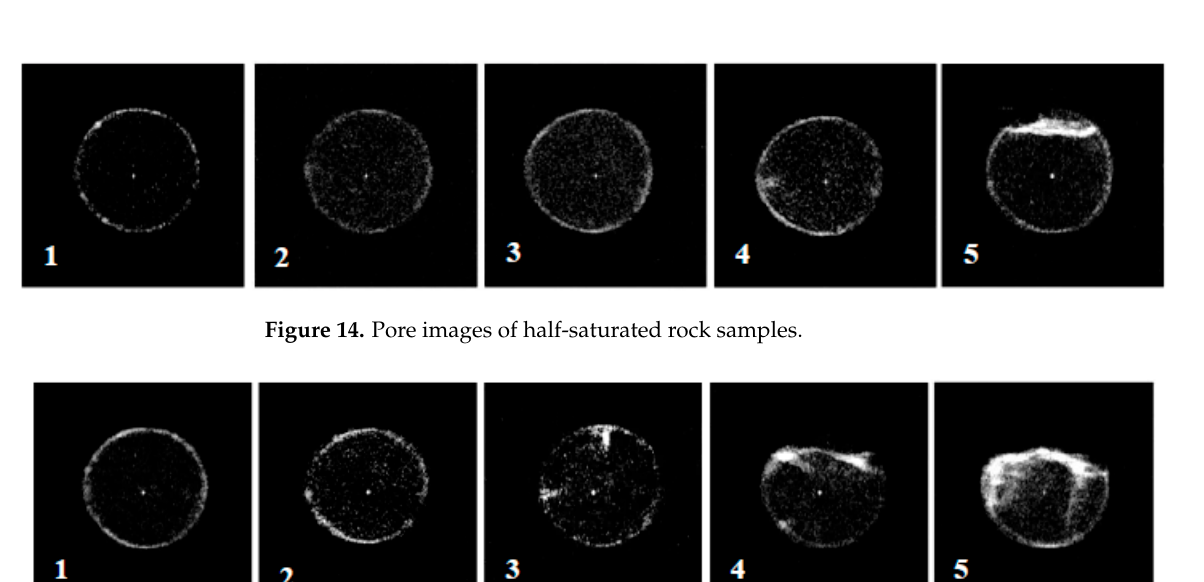
Figure 13. Pore images of dry rock samples.